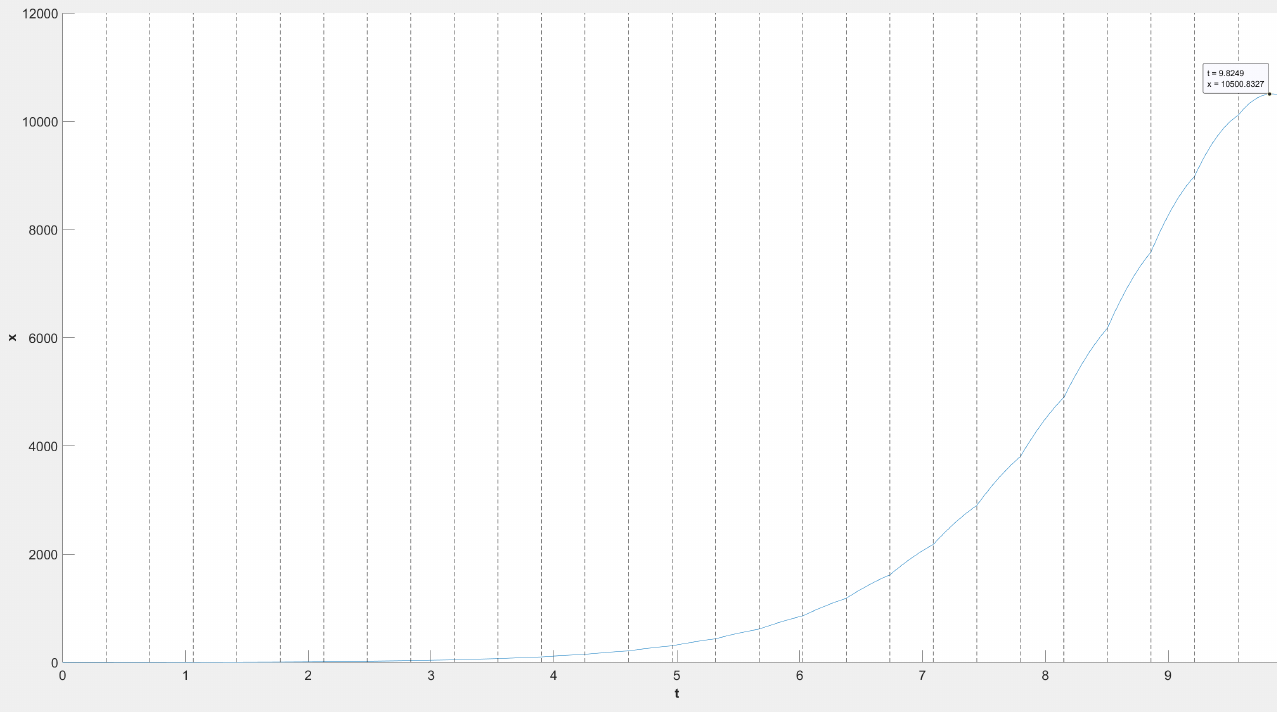
Figure 3. Solution with impulses of the derivative of x ( t ) ( δ = 2, τ =